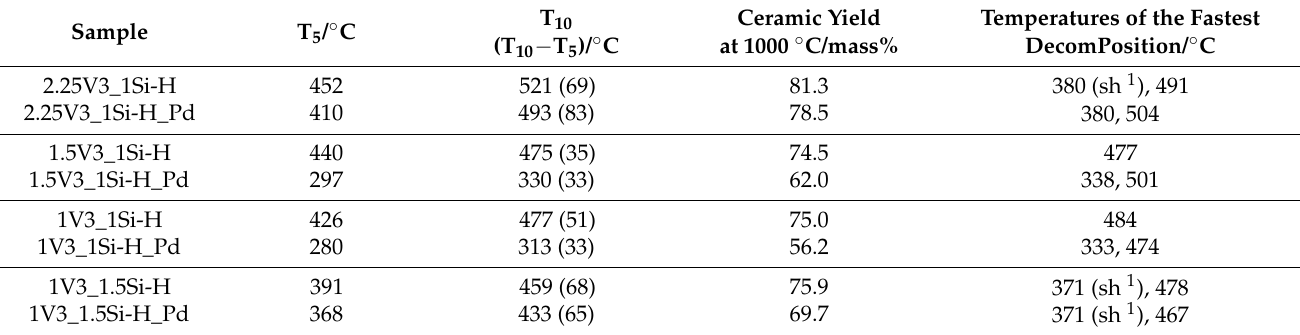
Table 4. Values of 5% mass loss (T 5 ), 10% mass loss (T 10 ), differences between T 10 and T 5 (T 10 − T 5 ), ceramic yields at 1000 ◦ C, and temperatures of the fastest decomposition of the analyzed